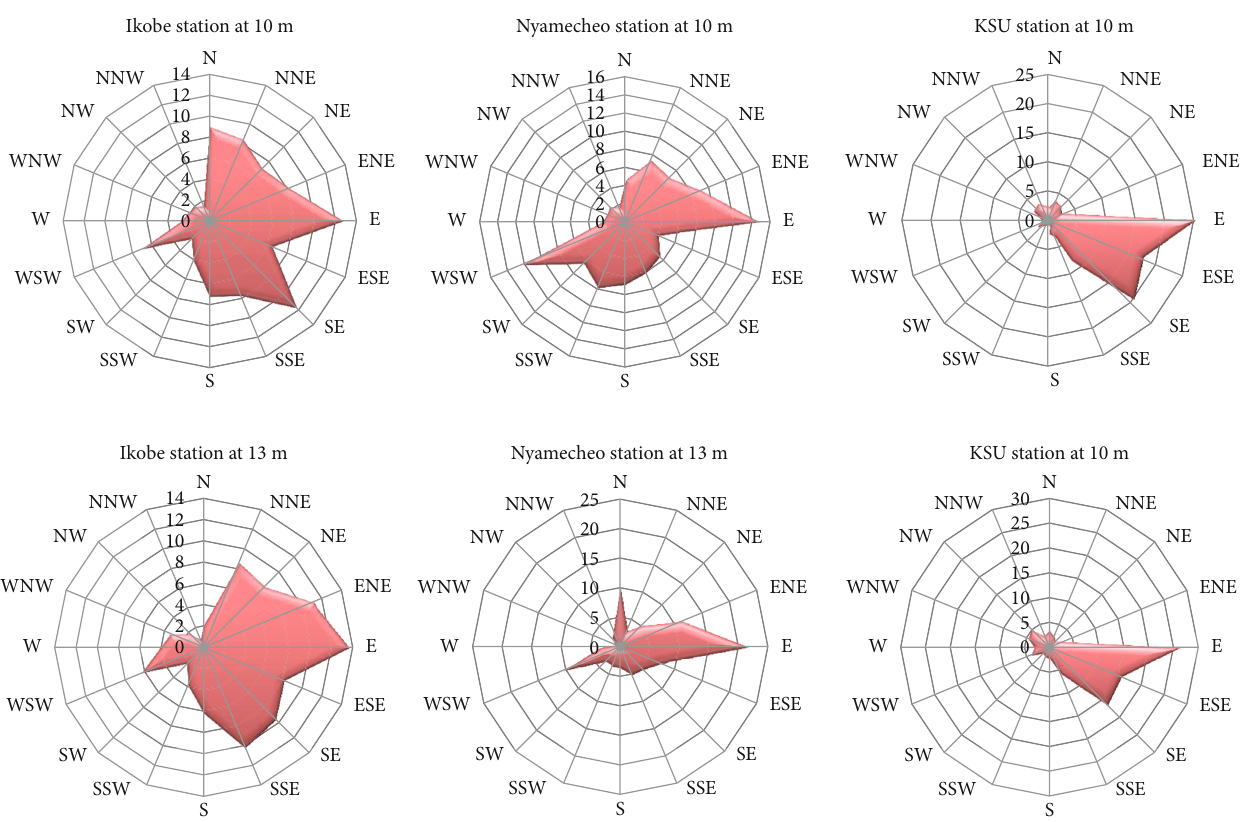
Figure 11: Directional analysis of wind from experimental data for the three